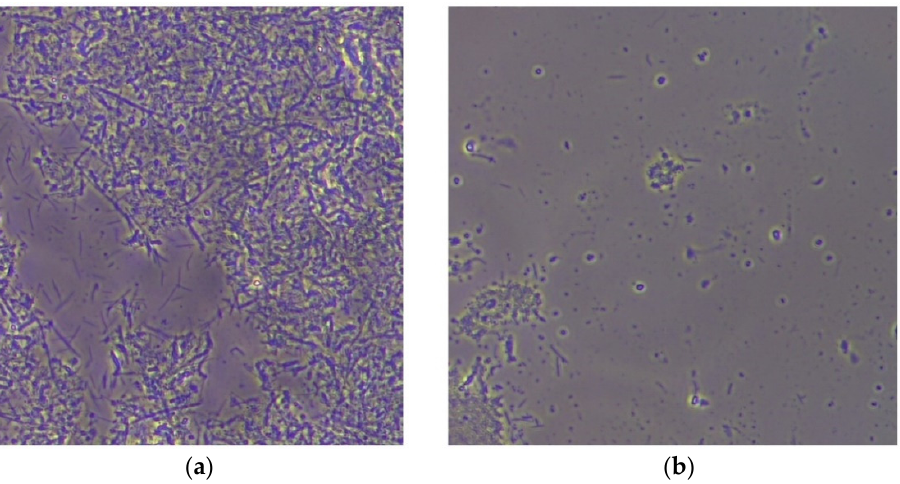
Figure 2. Dark-field microscope images of oral bacterial flora before treatment ( a ) and after treatment ( b ).